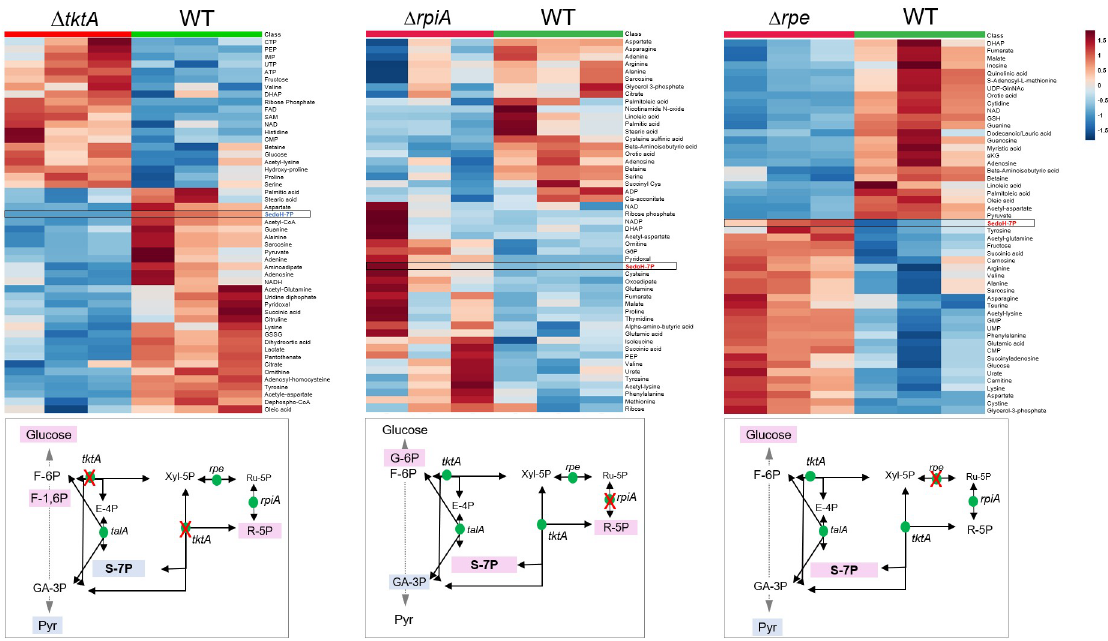
Fig 7. Comparison of metabolite profiles of WT and Δ tktA , Δ rpe and Δ rpiA mutants. Bacteria were cultured in TSB and collected during exponential phase of growth (at OD 600 of 0.5). Heatmap visualization and hierarchical clustering analysis of the metabolite profiling in each mutant compared to WT F . novicida . Upper part, heatmaps showing the top 50 ( Δ tktA , Δ rpe ) or top 30 ( Δ rpiA ) most changing compounds. Three biological replicates, performed for each sample, are presented. Rows: metabolites; columns: samples; color key indicates metabolite relative concentration value (blue: lowest; red: highest). The arrows, to the right of each heatmap, pinpoint the metabolites related to the PPP or glycolytic pathways. Lower part, the position of the metabolites related to the PPP or glycolytic pathways is shown on a schematic depiction of the